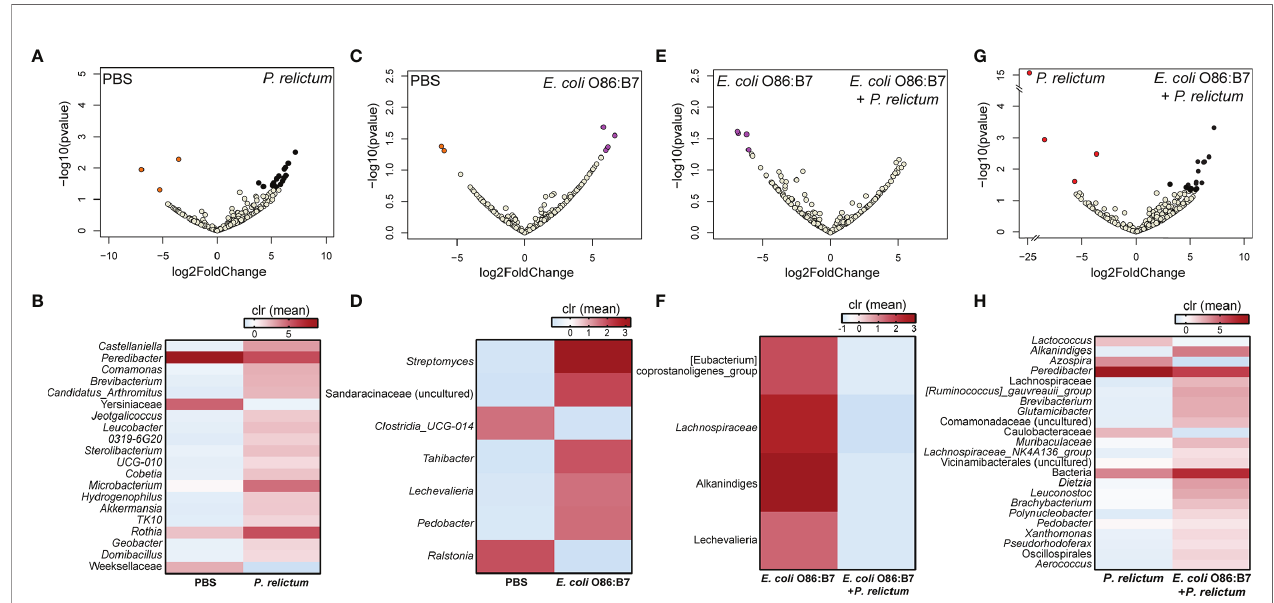
FIGURE 3 | Impact of E. coli O86:B7 vaccine and P. relictum infection on the taxonomic pro fi les of mosquito microbiota. Volcano plot showing the differential bacterial abundance in mosquito microbiota between different experimental groups (A) PBS vs . P. relictum , (C) PBS vs . E. coli O86:B7, (E) E. coli O86:B7 vs . E. coli O86:B7+ P. relictum and (G) P. relictum vs . E. coli O86:B7+ P. relictum. Taxa with signi fi cant differences (Wald test, p < 0.05) between the groups are represented with colored dots (i.e., orange, purple, red and black). The gray dots represent taxa with no signi fi cant differences between groups. Heatmaps representing the relative abundance (expressed as clr) of taxa with signi fi cant differences between (B) PBS vs . P. relictum , (D) PBS vs . E. coli O86:B7, (F) E. coli O86:B7 vs . E. coli O86:B7+ P. relictum and (H) P. relictum vs . E. coli O86:B7+ P. relictum. Taxa with signi fi cant differences in their abundance were identi fi ed using DeSeq2 algorithm. The taxonomic pro fi les were obtained from 16S rRNA sequences from midgut of mosquitoes fed on mock-immunized (n = 5 mosquitoes midgut pool), E. coli O86: B7-immunized (n = 5 mosquitoes midgut pool), E. coli O86:B7-immunized and challenged with P. relictum (n = 8 mosquitoes midgut pool) and challenged only with P. relictum (n = 8 mosquitoes midgut